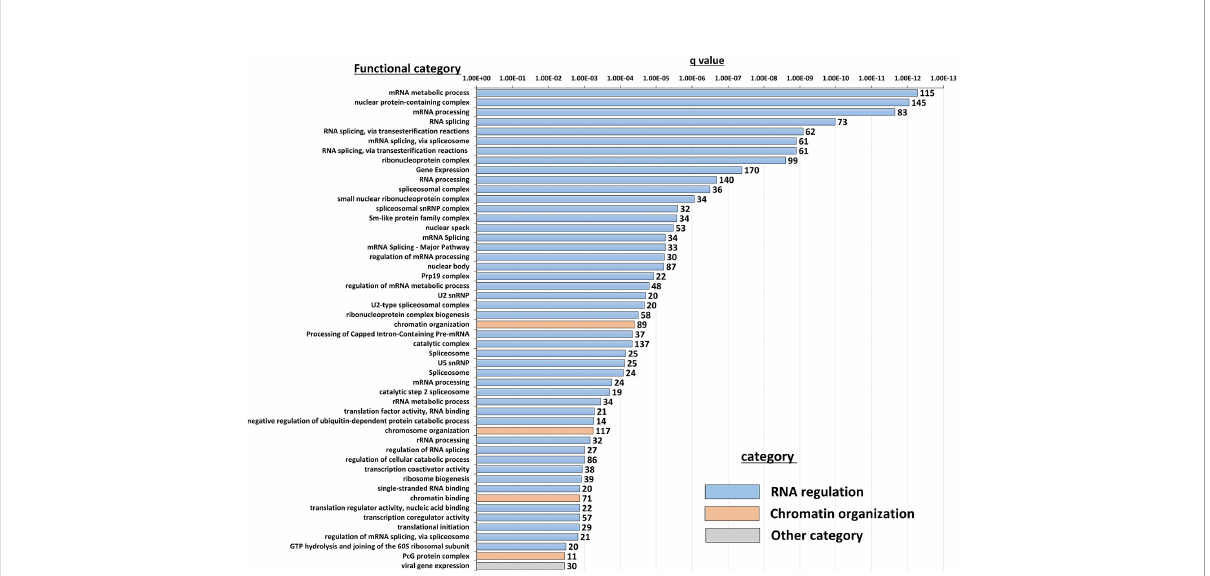
FIGURE 5 Functional annotation enrichment of the B-ALL NBDG-low expression signature. Differentially-expressed transcripts (p<0.05) in low glucose uptake B-ALL PDX subpopulations (i.e., relative to medium glucose uptake subpopulations) were identi fi ed as described above in Figure 3 and Materials and Methods. Functional annotation enrichment analysis was then performed using ToppFun on the list of DETs as input. The enriched categories classi fi ed in GO; Molecular Functions, GO; Biological Process, GO; Cellular Component and Pathway were selected, and then the representative top 50 enriched functional categories and gene sets (y-axis) are displayed in the chart along with the Enrichment q-value (x-axis) and the number of gene hits from the NBDG-low expression pro fi le in each category (data